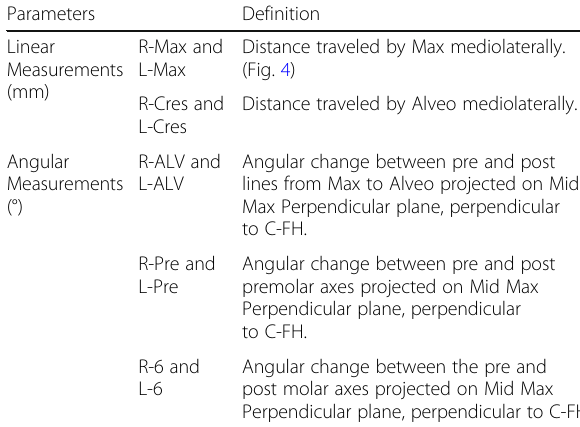
Table 3 Definition of measurements for structures affected